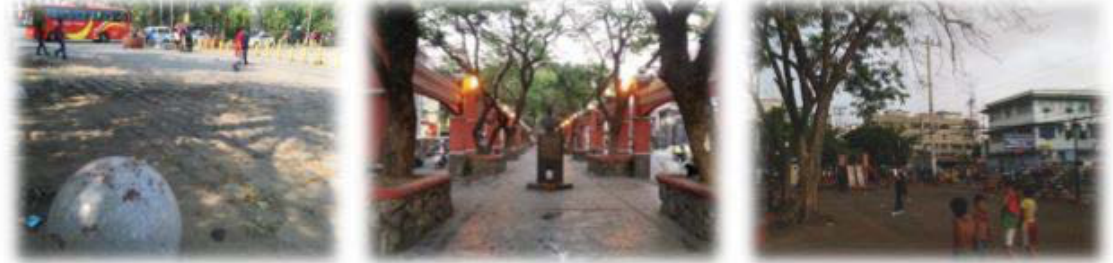
Figure 4. Photos showing condition of inventoried urban green spaces